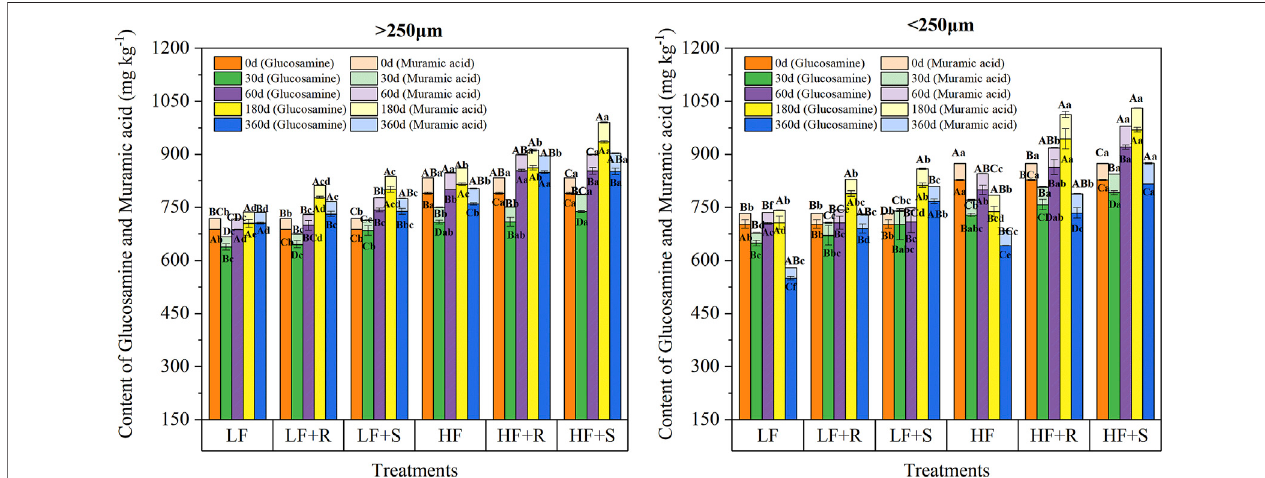
FIGURE2| Contentsofglucosamineandmuramicacidinsoilaggregateswithdifferentfertilitylevelsafter theadditionofdifferentpartsofmaizeresidues. Note:LF meanslowfertility,LF+Rmeanslowfertility+roots,andLF+Smeanslowfertility+Shoots;HFmeanshighfertility,HF+Rmeanshighfertility+roots,andHF+Smeans high fertility + Shoots. Uppercase letters represent differences between different periods in the same treatment, and lowercase letters represent differences between different treatments at the same period.